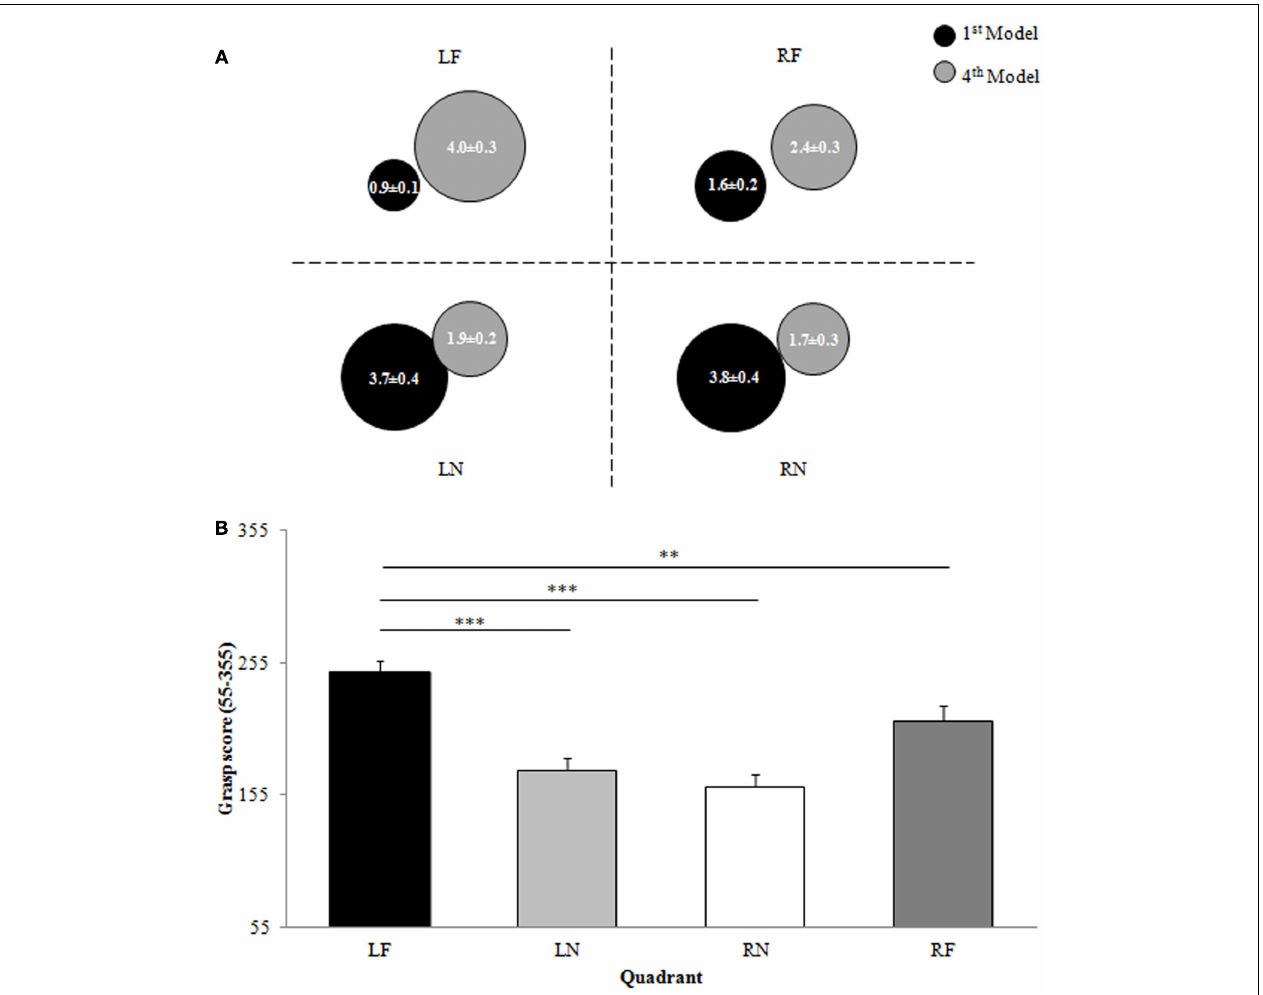
errors. (B) Overall grasp score for each quadrant of reachable space. Data are means and standard errors. LF, left far; LN, left near; RN, right near; RF, right